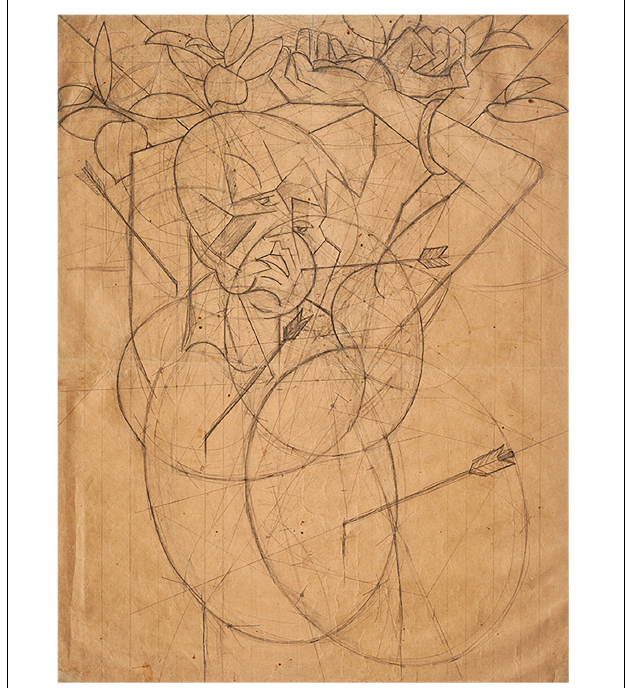
FIGURE 2 | Bohumil Kubišta, Study for Saint Sebastian, 1912. Pencil on paper, 95 × 74 cm. Collection of National Gallery,